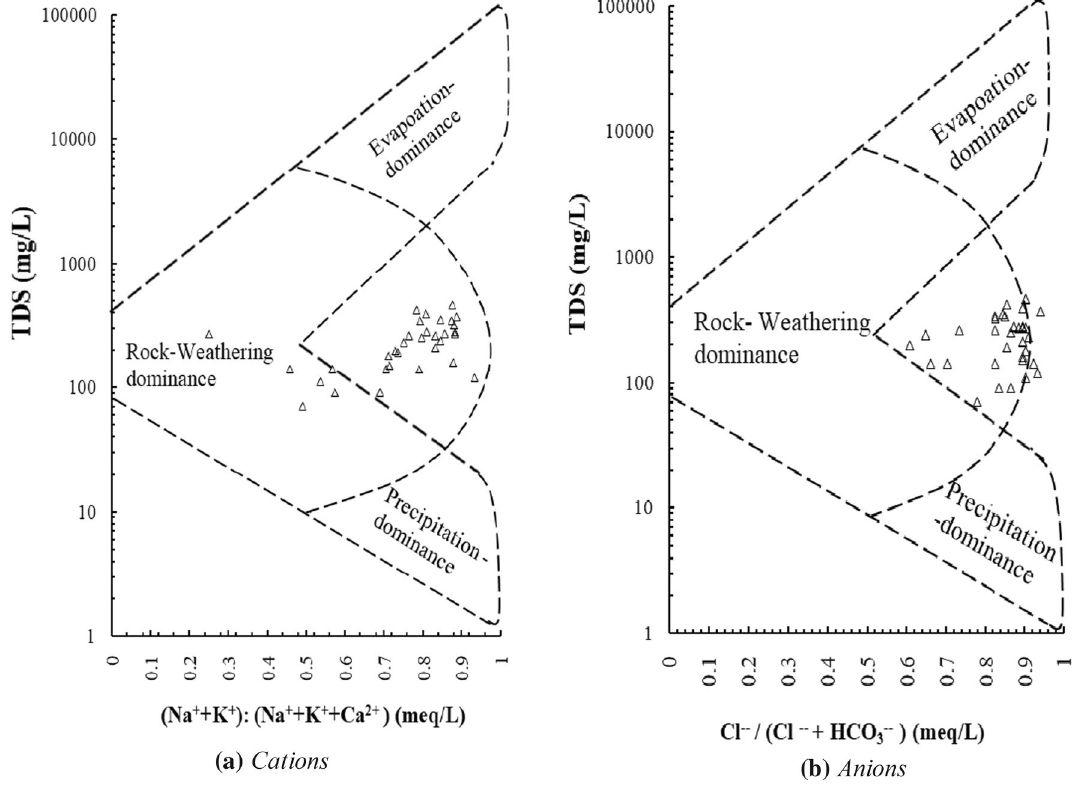
Fig. 5 Gibbs diagram showing rock weathering as a dominant geochemical process for dissolution of a cations and b anions in the groundwater samples for the study